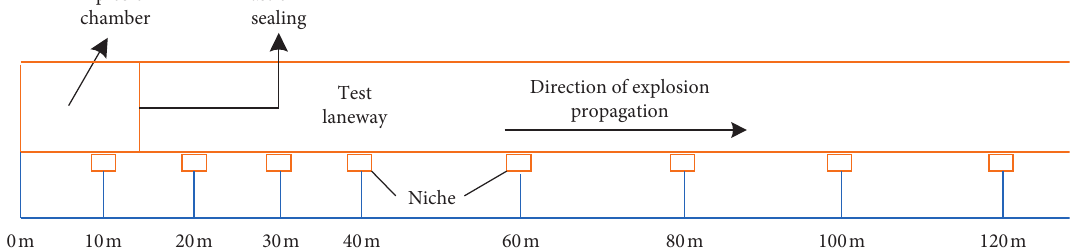
Figure 2: Layout of the niches.